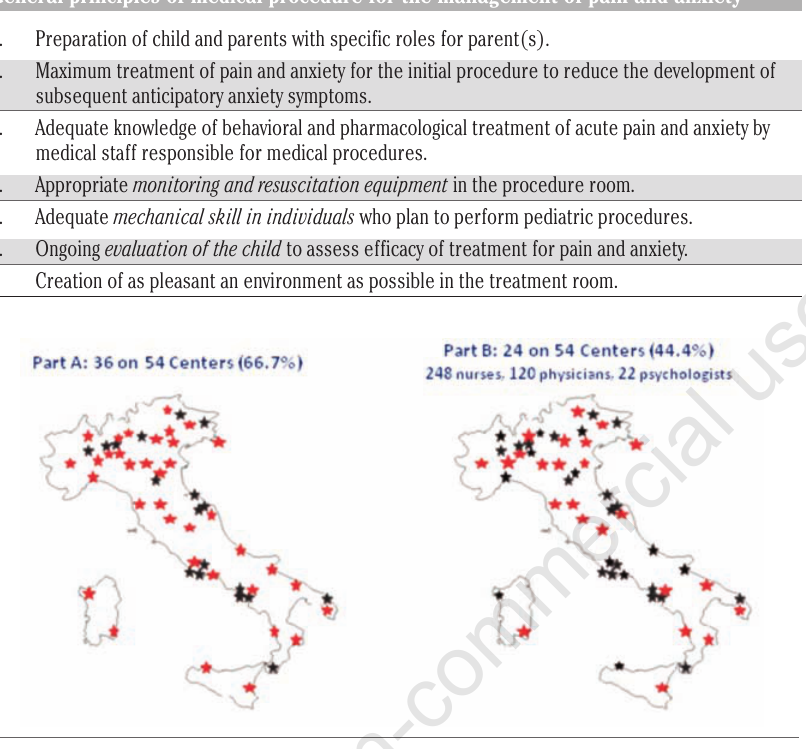
Figure 1. Participation in our survey conducted in 2010 among Centers of the Italian Association of Pediatric Hematology-Oncology (red starlets=responders; black starlets=non